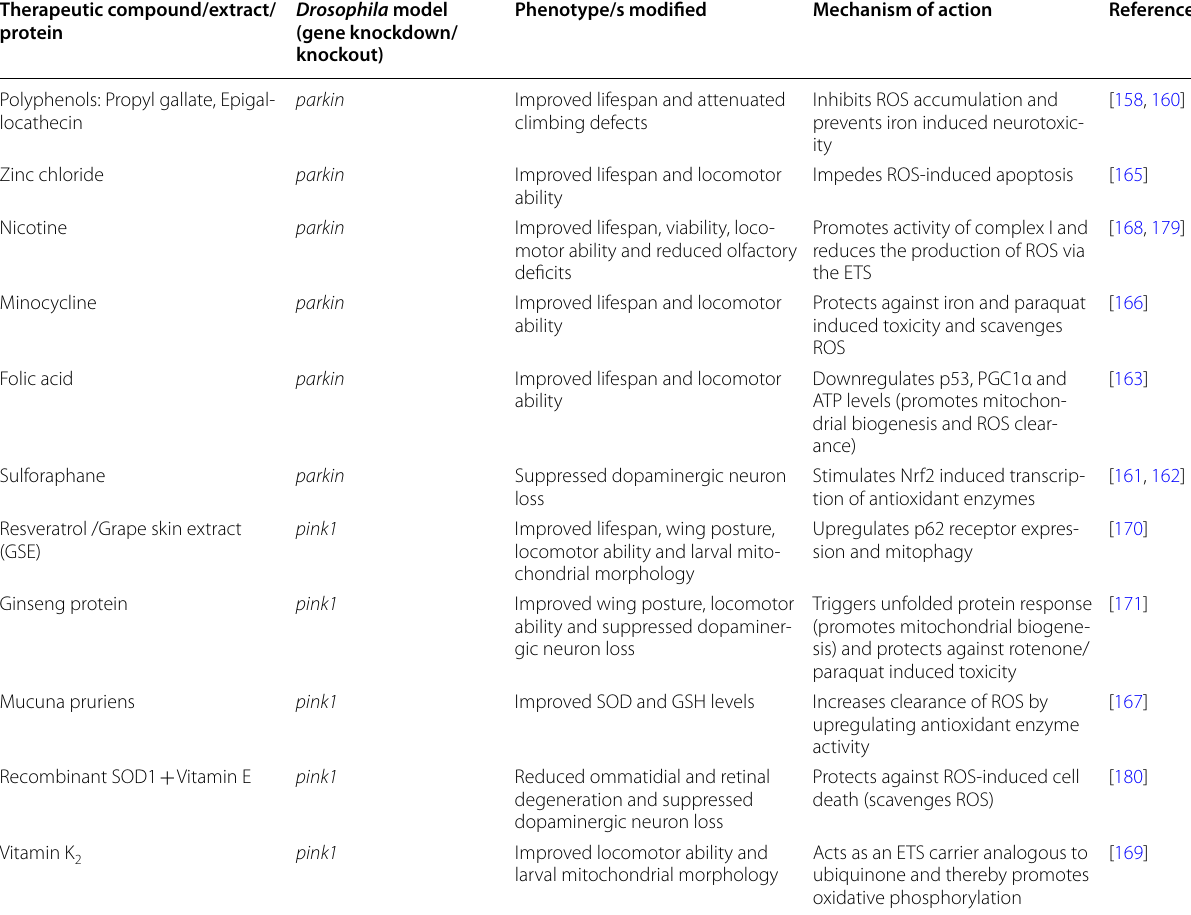
Table 1 Therapeutic compounds/extracts tested in Drosophila PINK1/Parkin models Therapeutic compound/extract/